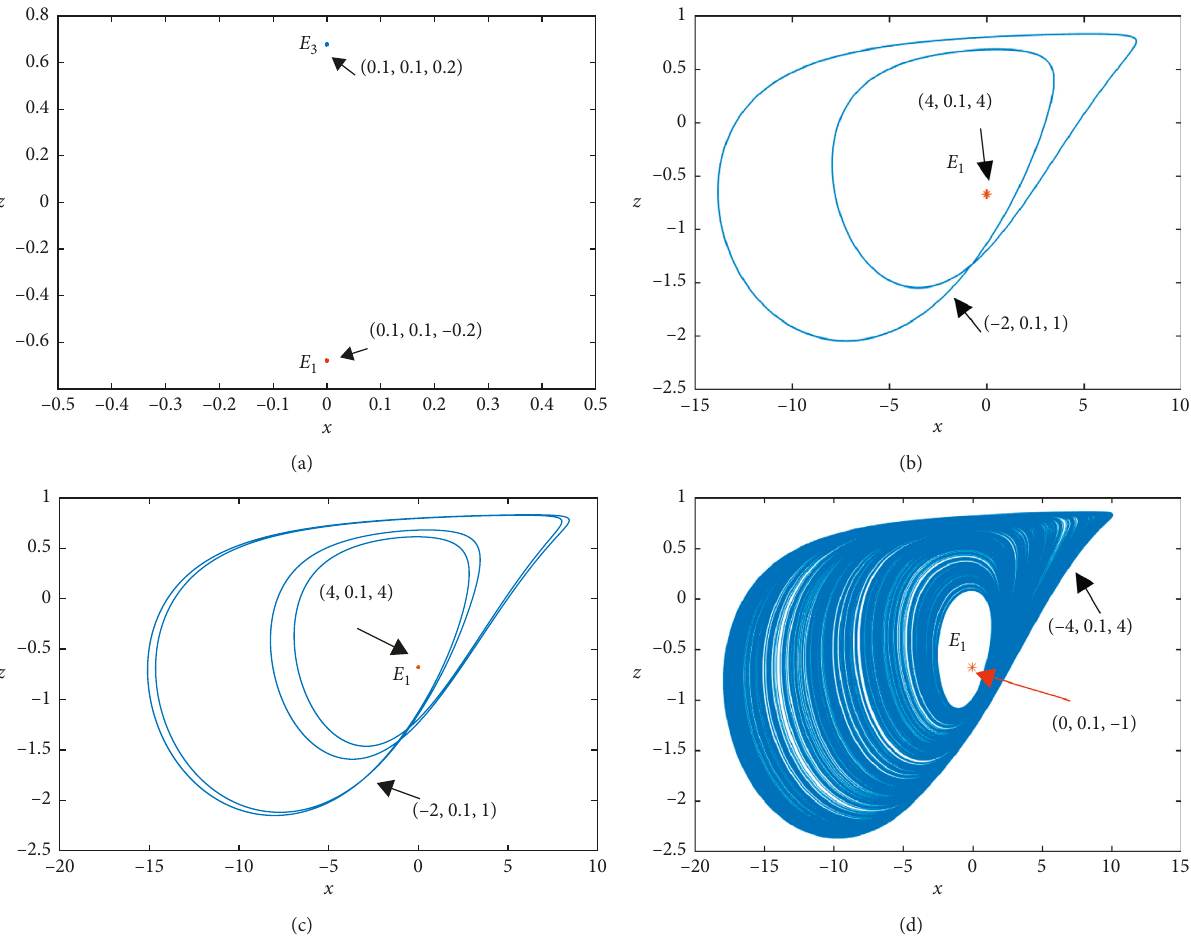
Figure 4: Bistability behaviors with different fractional orders. (a) α � 0.75, two sets of the initial values (0.1, 0.1, 0.2) and (0.1, 0.1, − 0.2); (b) α � 0.96 and two sets of the initial values (4, 0.1, 4) and ( − 2, 0.1, 1); (c) α � 0.97 and two sets of the initial values (4, 0.1, 4) and ( − 2, 0.1, 1); (d) α � 0.99 and two sets of the initial values ( − 4, 0.1, 4) and (0, 0.1, −